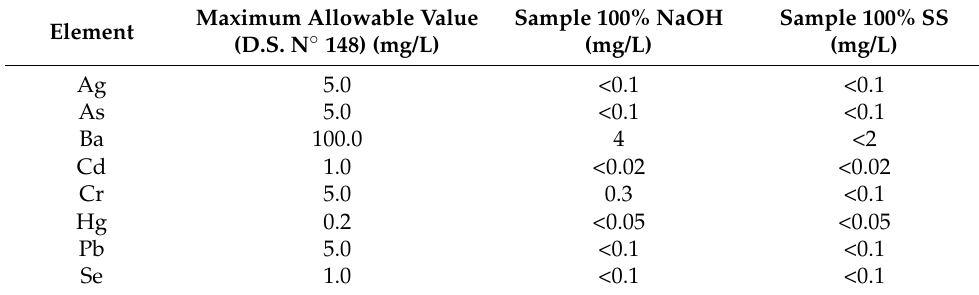
Table 8. TCLP test results to